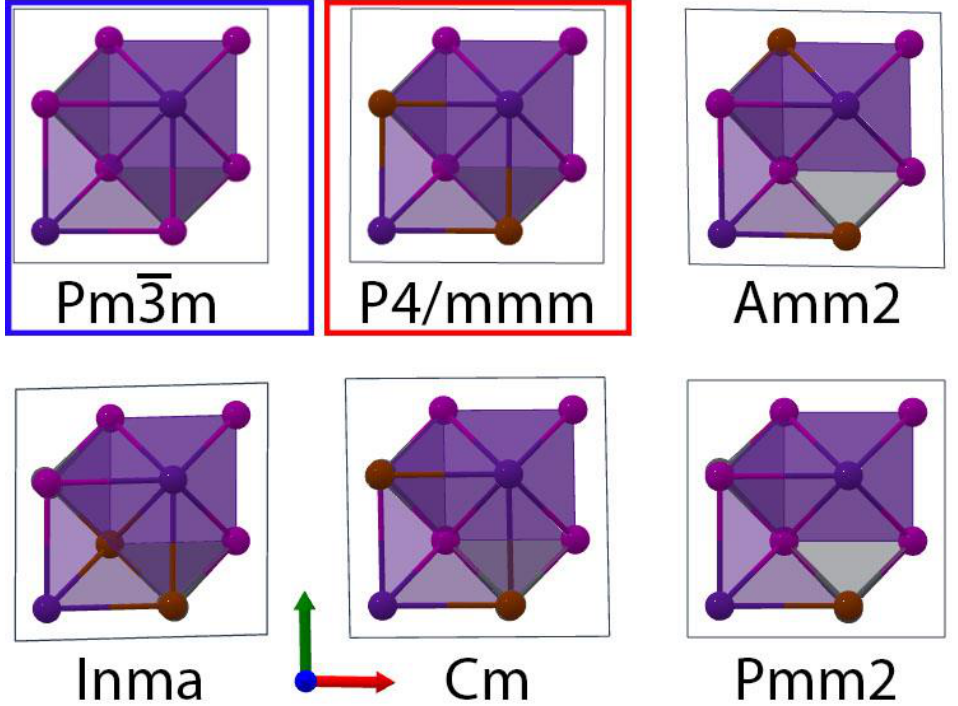
Figure 1. The crystal structures of the α -CsPbI 3 𝑃𝑚3̅𝑚 (blue box) and α -CsPbI 2 Br P4/ mmm (red box) phases, and all other α -CsPbI 2 Br phases considered. The perspective is down the c -axis of the crystals with the lead atoms eclipsed by halides to better represent the halide substitutions.